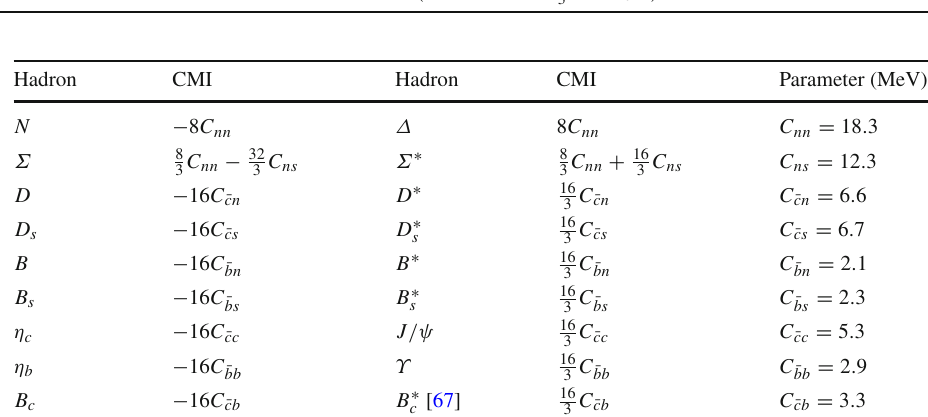
obtained with mass splittings of conventional mesons and